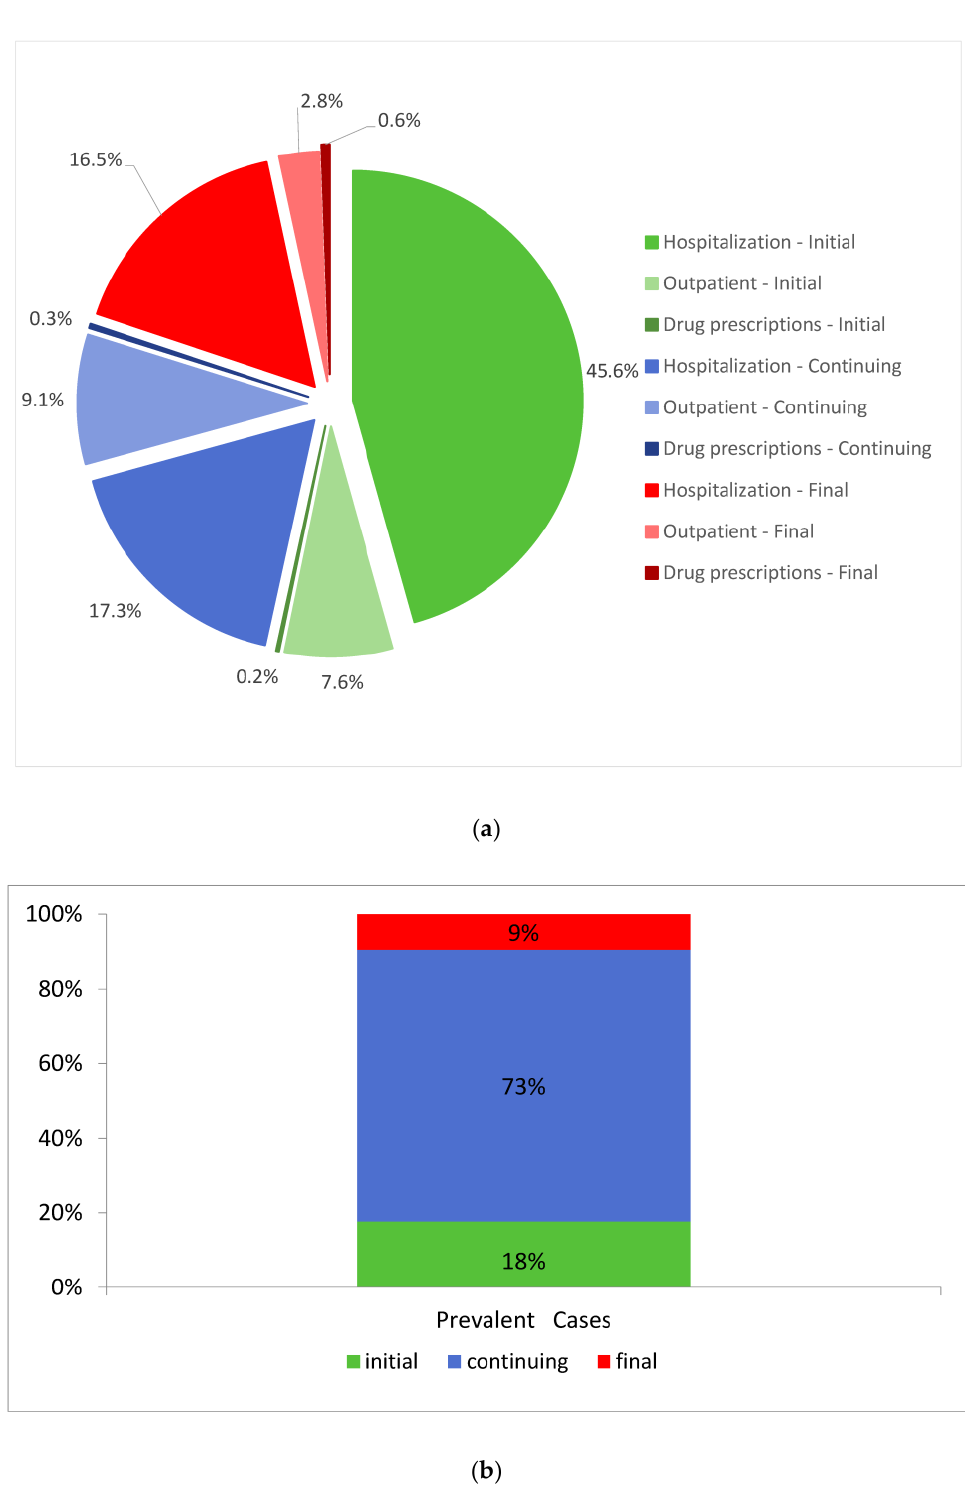
Figure 2. Distribution of total annual costs ( a ) and prevalent cases ( b ) by type of service and phase of care. Pool of CRs. 18% of cases are in initial phase of care, and absorb about 53% of costs (45.6% hospi-